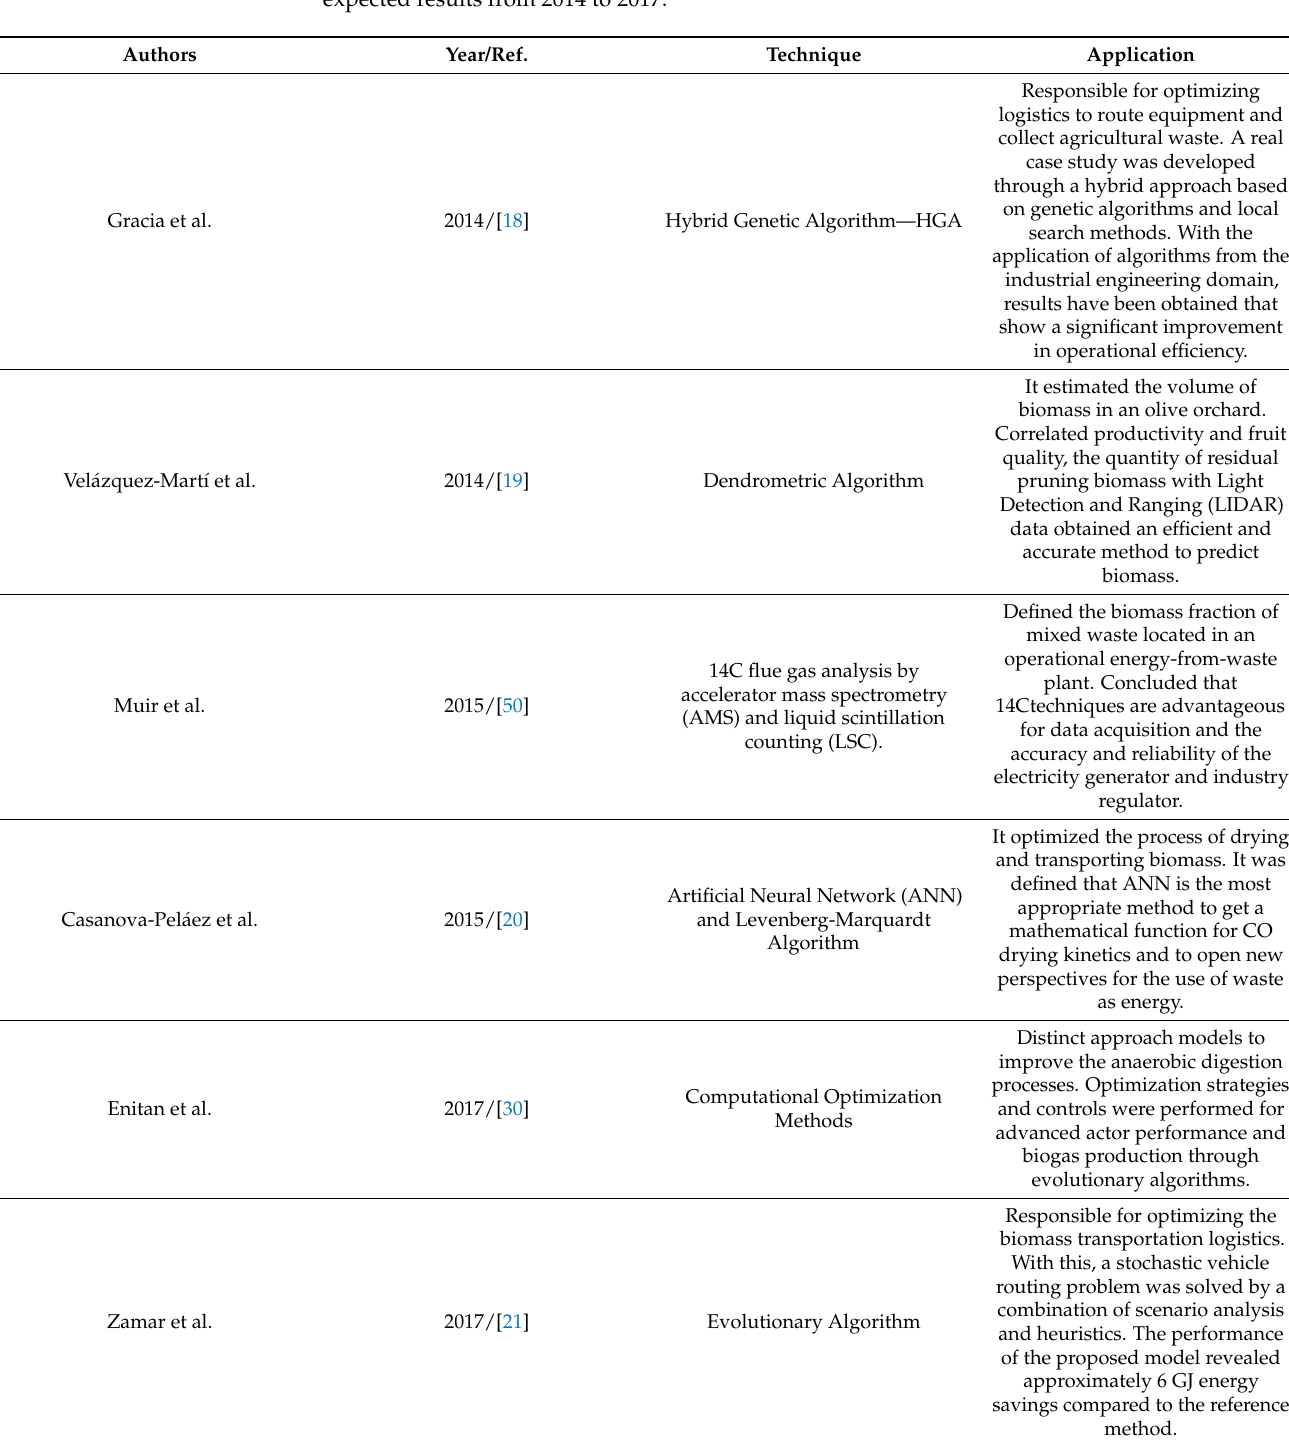
Table A2. Algorithm models identified in the analysis portfolio as well as their applications and expected results from 2014 to